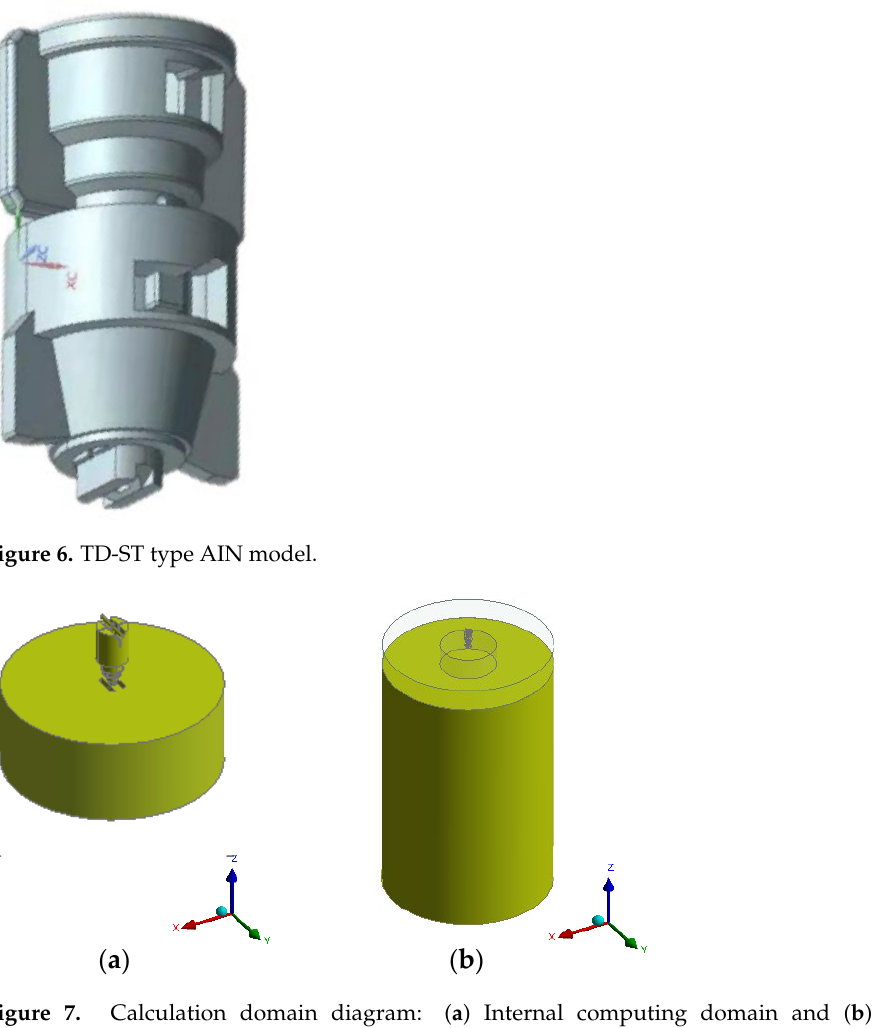
Figure 7. Calculation domain diagram: ( a ) Internal computing domain and ( b ) external computing domain.